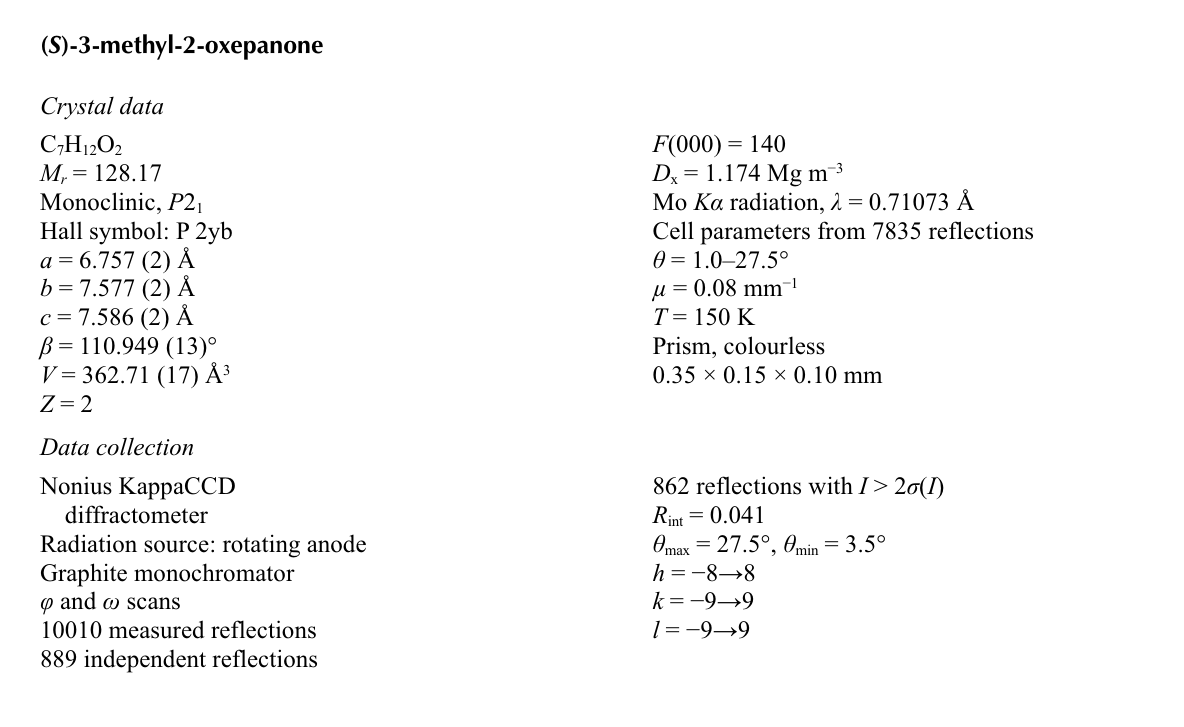
The packing of one layer found in the crystal structure of (I) viewed down the a* direction. Molecules are connected by short C–H···O contacts in the (1 0 0) plane. Only one set of short contacts (dashed lines) is shown for clarity. The symmetry codes are: ( i ) 2 - x , -1/2 + y , - z ; ( iii ) 2 - x , 1/2 + y , - z ; ( iv ) x , y , z -